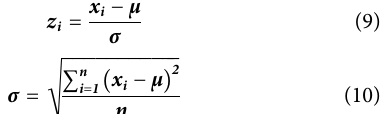
(Figure 3; Table 3), indicating that human activities had increased signi fi cantly. From 2000 to 2010, the average nighttime light intensity of the giant panda distribution area